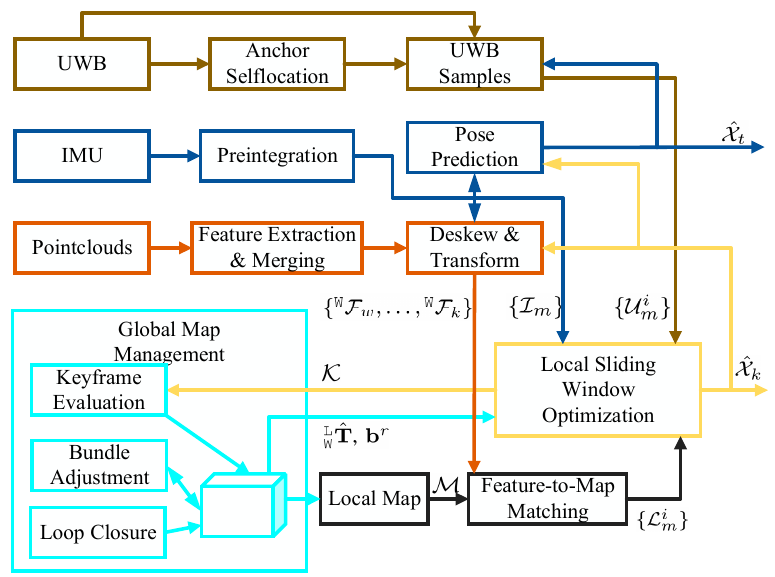
Figure 2. Overview of the location and mapping, however in this system we only focus on loca- tion.